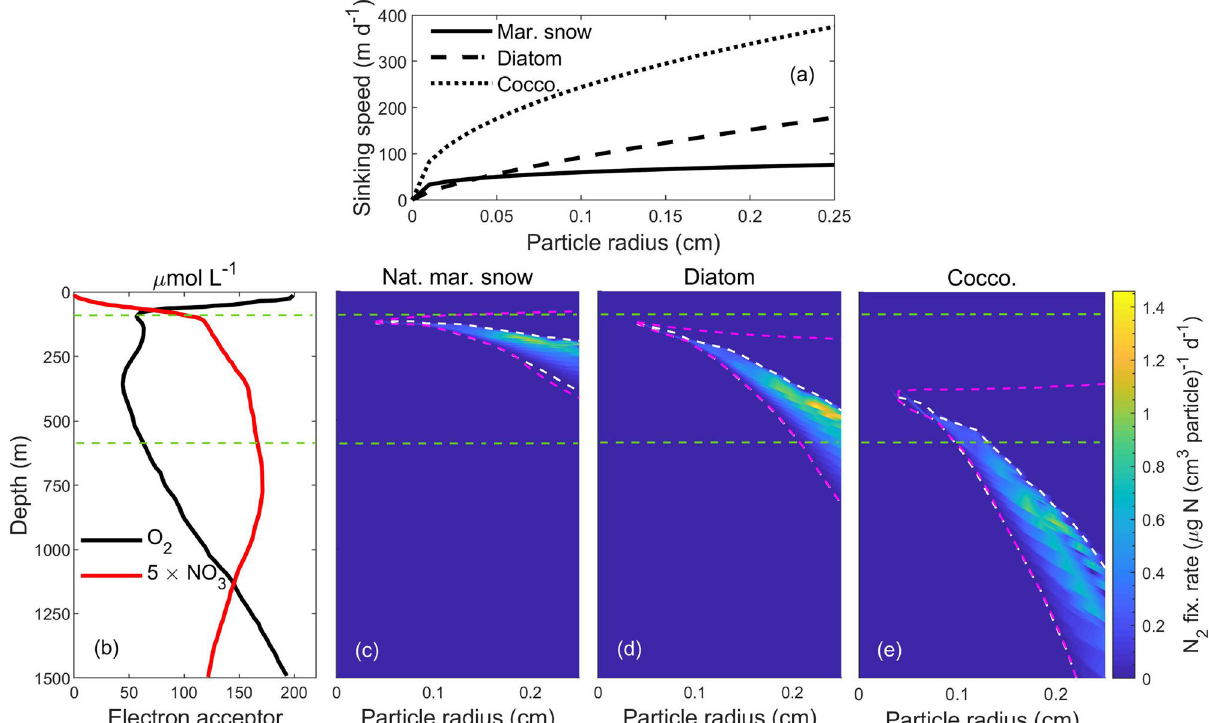
Fig. 7 N 2 fi xation rates in different types of sinking particles with different sinking speeds. a Particle radius (cm) versus sinking speeds (m d − 1 ) of natural marine snow (continuous line) measured in situ off California ( v ¼ 108 : 95 ´ r P 0.26 ; 61 ) and of laboratory-made diatom (dashed line) and coccolithophore (dotted line) aggregates measured in vitro ( v ¼ 484 : 09 ´ r Mauritanian upwelling zone in the North Atlantic Ocean (NAO) 55 . c – e N 2 fi xation rates per unit volume of particles of different sizes and types. White and magenta dashed lines are same as in Fig. 6. The area enclosed within the horizontal green lines represents the low-O